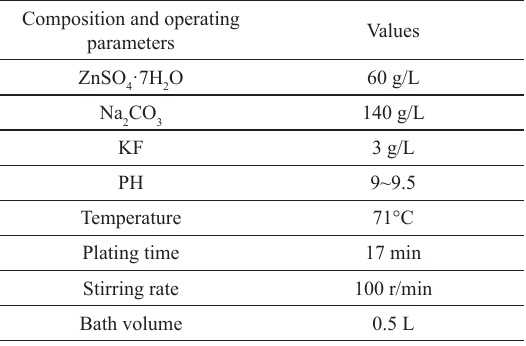
Table 1. The formulation and process of zinc immersion reaction.